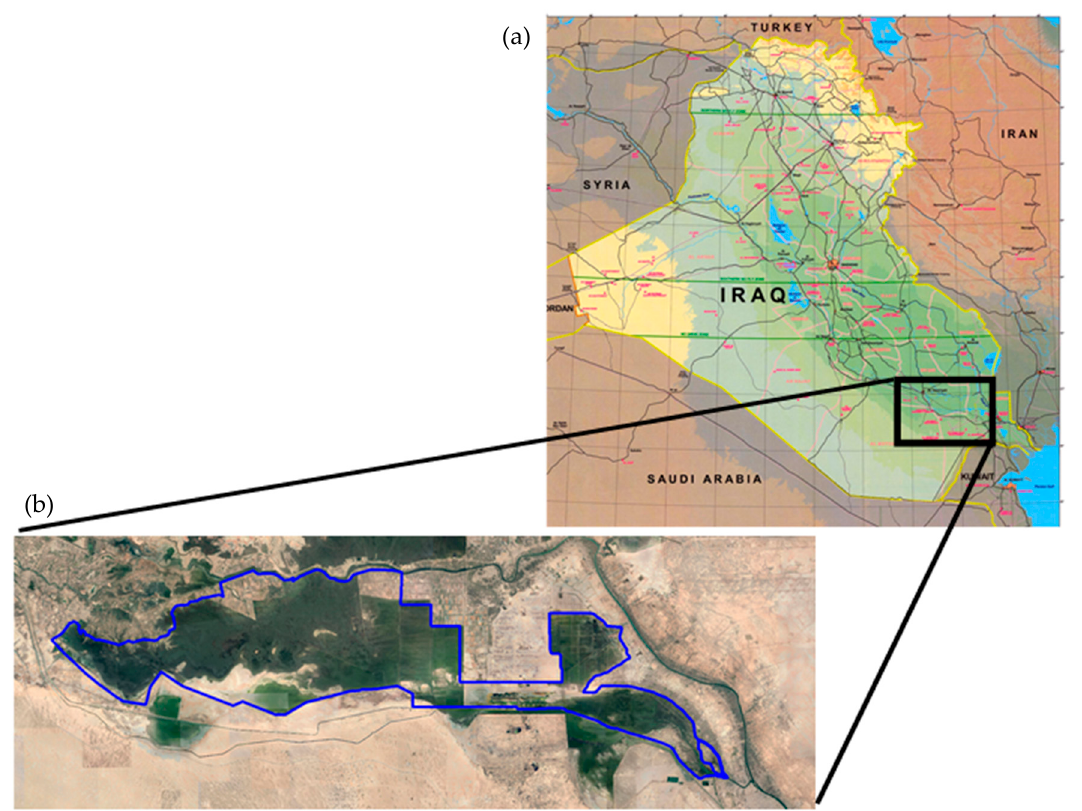
Figure 1. ( a ) Map of Iraq. ( b ) Satellite image showing the geographic location of the Al Hammar marsh with the boundary set by CRIM [28].